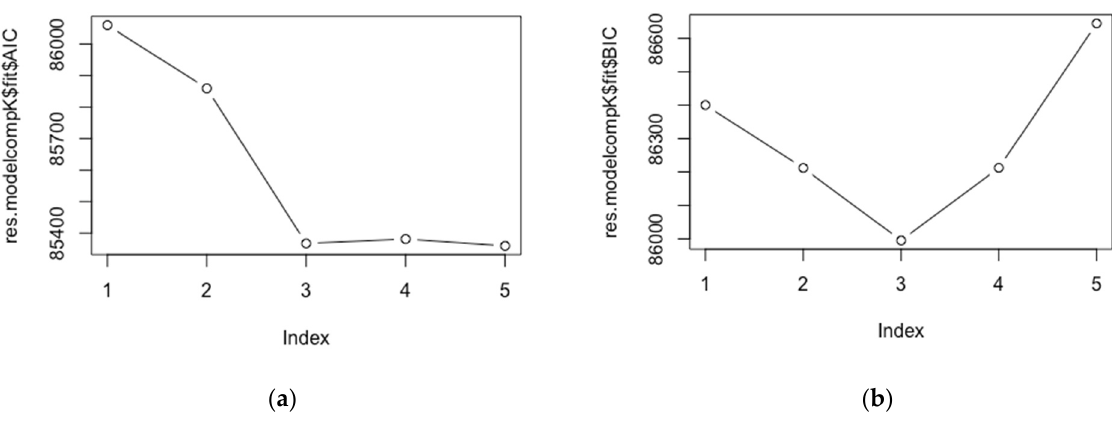
Figure 2. ( a ) The scatterplot of AIC; ( b ) The scatterplot of